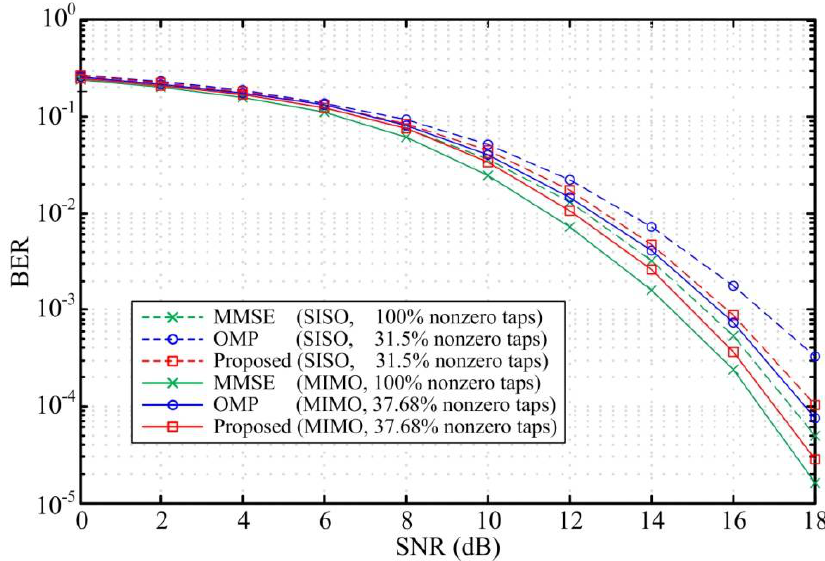
Figure 5. BER versus SNR for SISO DFEs and MIMO DFEs in the exponential decay channel with η max = 0.6 dB and N f = 50.